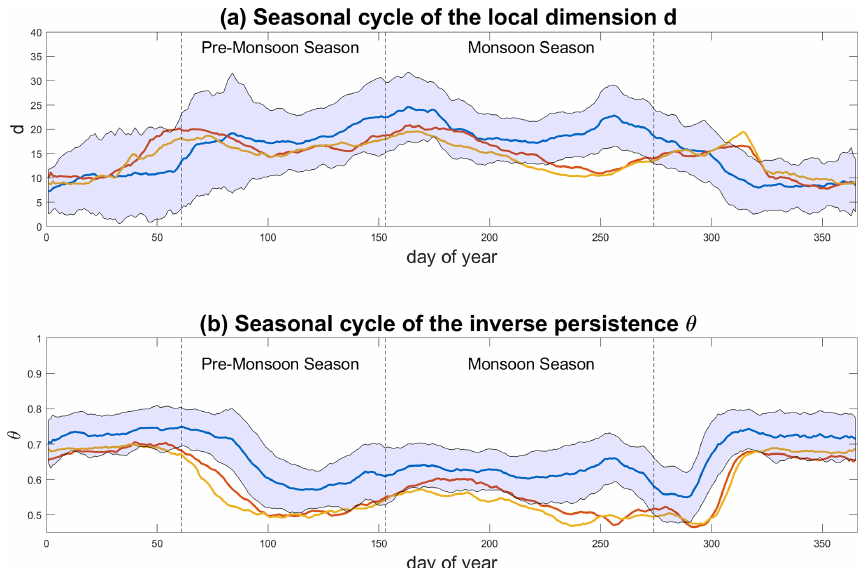
Figure A2. The same as Fig. 3a and b but using the domain 10–30 ◦ N, 15 ◦ W–20 ◦ E.